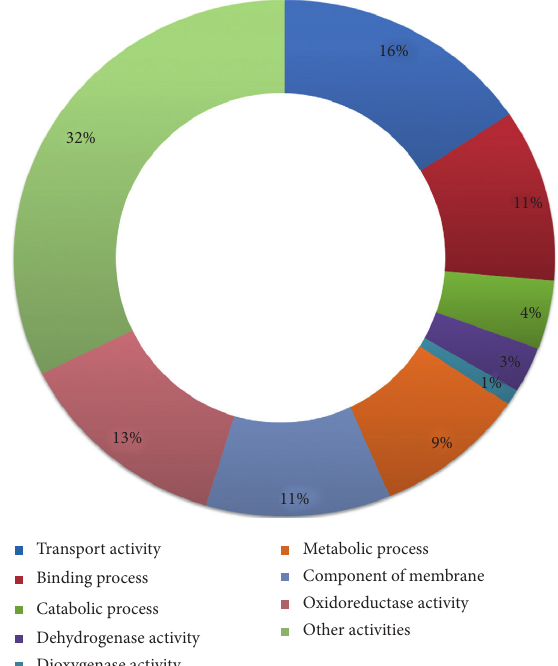
Figure 3: Distribution of genes differentially expressed by func- tional groups (GO